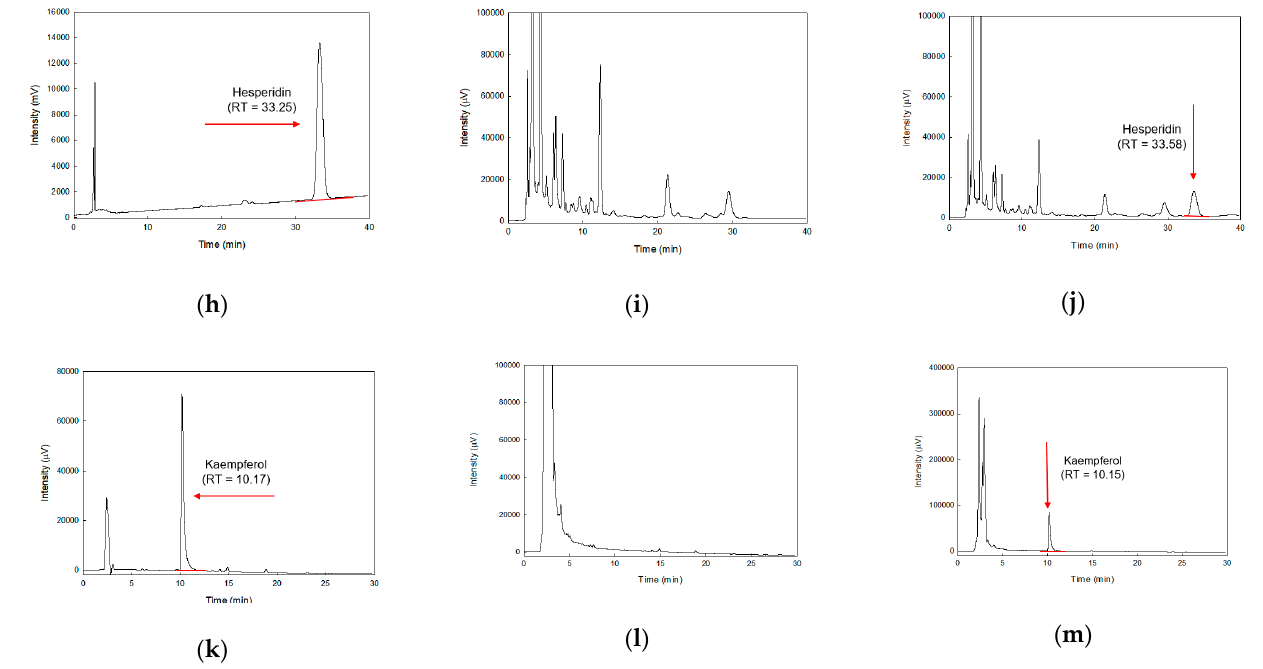
Figure 1. Effects of As-EE on antioxidative capacity. ( a ) As-EE (0 to 200 µ g/mL) was incubated with DPPH (250 µ M) in foil at 37 ◦ C for 30 min and then the absorbance was measured at 517 nm. Ascorbic acid (50 µ M) together with positive controls; ( b ) ABTS and potassium persulfate solution mixed with As-EE (0 to 200 µ g/mL) incubated for 30 min in the dark at 37 ◦ C. At 730 nm, the solution’s absorbance was found; ( c ) Copper(II) chloride solution, neocuproine solution, and NH 4 Ac buffer were mixed with As-EE (0 to 200 µ g/mL). Trolox (0.4 mM) was used as a positive control. After 1 h of incubation, the absorbance was measured at 450 nm using a spectrophotometer; ( d ) Acetic acid buffer, TPTZ solution, and FeCl 3 solution were mixed with As-EE (0 to 200 µ g/mL). A positive control was employed, which was trolox (0.4 mM). Each fraction’s absorbance was measured at 593 nm after 15 min of dark incubation at 37 ◦ C; ( e – m ) The phytochemical profiles of rutin, quercetin, hesperidin, and kaempferol in As-EE were analyzed using HPLC. Results ( a – d ) are expressed as the mean ± standard deviation. # p < 0.05 and ## p < 0.01 compared with the normal groups. * p < 0.05 and ** p < 0.01 compared with the control groups.